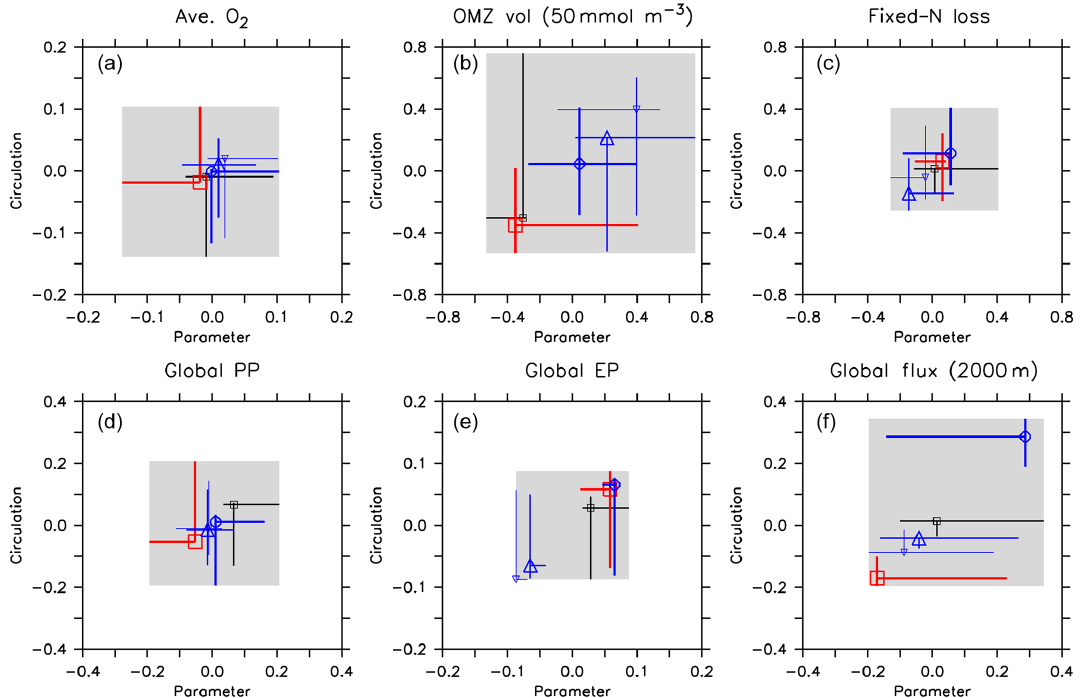
Figure 12. Effect of variation in circulation and biogeochemical parameters on normalised diagnostics. (a) Global average oxygen, (b) OMZ volume defined by a concentration of < 50mmolm − 3 , (c) global fixed-nitrogen loss, (d) global primary production, (e) export production and (f) organic particle flux at 2000m. All diagnostics X are expressed as relative deviation from mean of the five optimal model simulations − 1), where j and i denote different combinations of circulation j and parameter set i , and X ∗ ( X i,j /X ∗ is the average of all optimal model j j configurations (see Table 3 for values). Each panel shows the range of the normalised diagnostic when the parameter set is kept constant and circulation varied (vertical lines) and when circulation is kept constant and the parameter set is varied (horizontal lines). Symbols denote the optimal model configuration. Colour denotes circulation and optimal parameter set. Black: circulation MIT28 or parameter set of MIT28 ∗ . Thick blue: UHigh and UHigh ∗ . Medium blue: U20 and U20 ∗ . Thin blue: U17.5 and U17.5 ∗ . Red: ECCO and ECCO ∗ . Symbols denote optimal model configurations (see also symbol legend in Fig. 6). The grey shaded area shows total variation across all 25 model experiments, corresponding to (cid:49) All in Table 3. Note that the maximum variation due to the parameter within each circulation ( (cid:49) Par of Table 3) is given by the longest horizontal line in each panel. Likewise, the maximum variation due to circulation within each parameter set ( (cid:49) Circ of Table 3) is given by the longest vertical